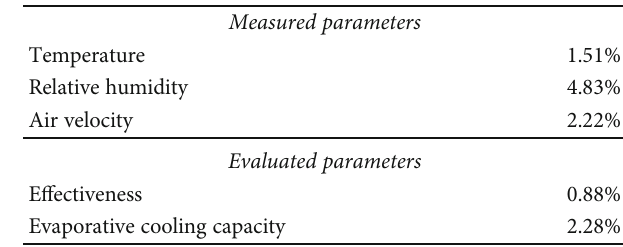
Table 3: Uncertainties in measured parameters and evaluated